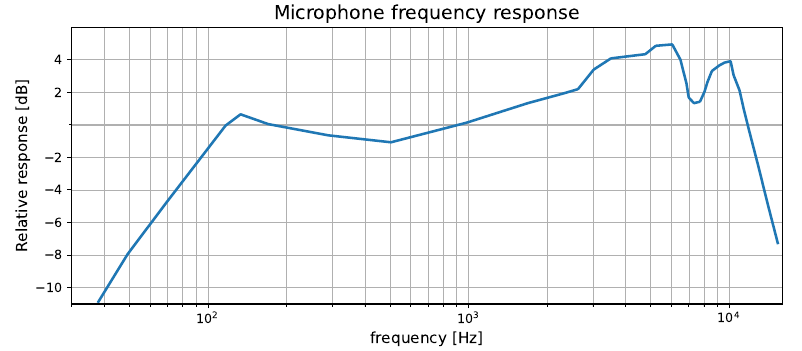
Figure 5. Frequency response of smartphone microphone used in